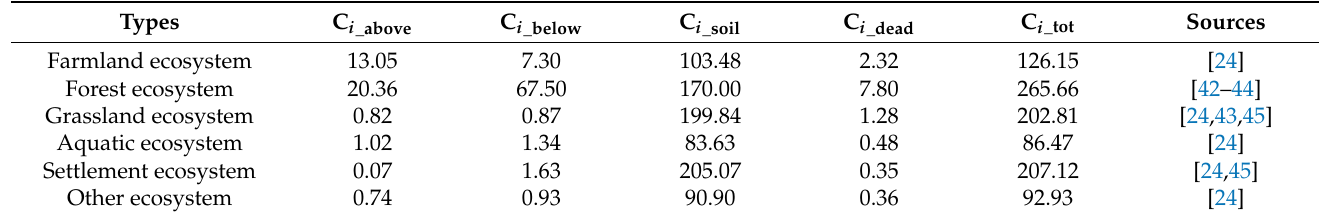
Table 3. Carbon density of the Guizhou terrestrial ecosystem (Mg/hm 2 ).